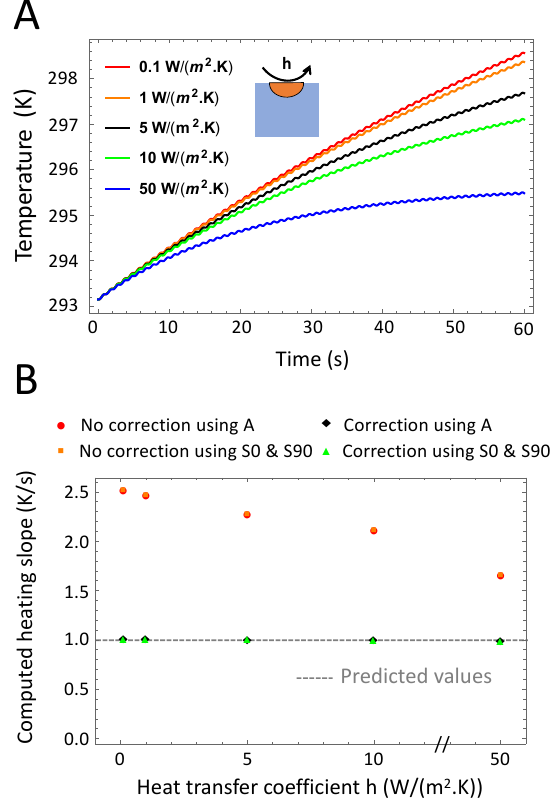
Figure 5. Variations of the heat loss coefficient. ( A ): Time-dependent temperature of the sample for different Newton coefficients h . For high h values, the thermal relaxation phase is shorter. ( B ): Computed β (normalized) for different values of h . Correction for the initial heating is required especially for high h values, for which the thermal relaxation phase is longer. β calculations using the in-phase and in-quadrature signal or the amplitude signal alone lead to similar